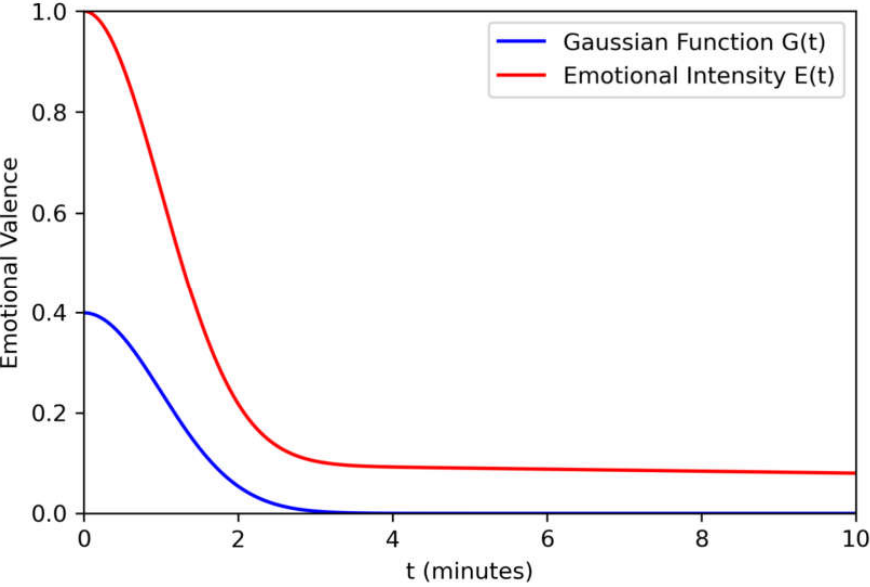
Figure 2. A typical distribution graph of emotional valence with the parameters ( σ : 1, s : 0.1, d : 0.002).